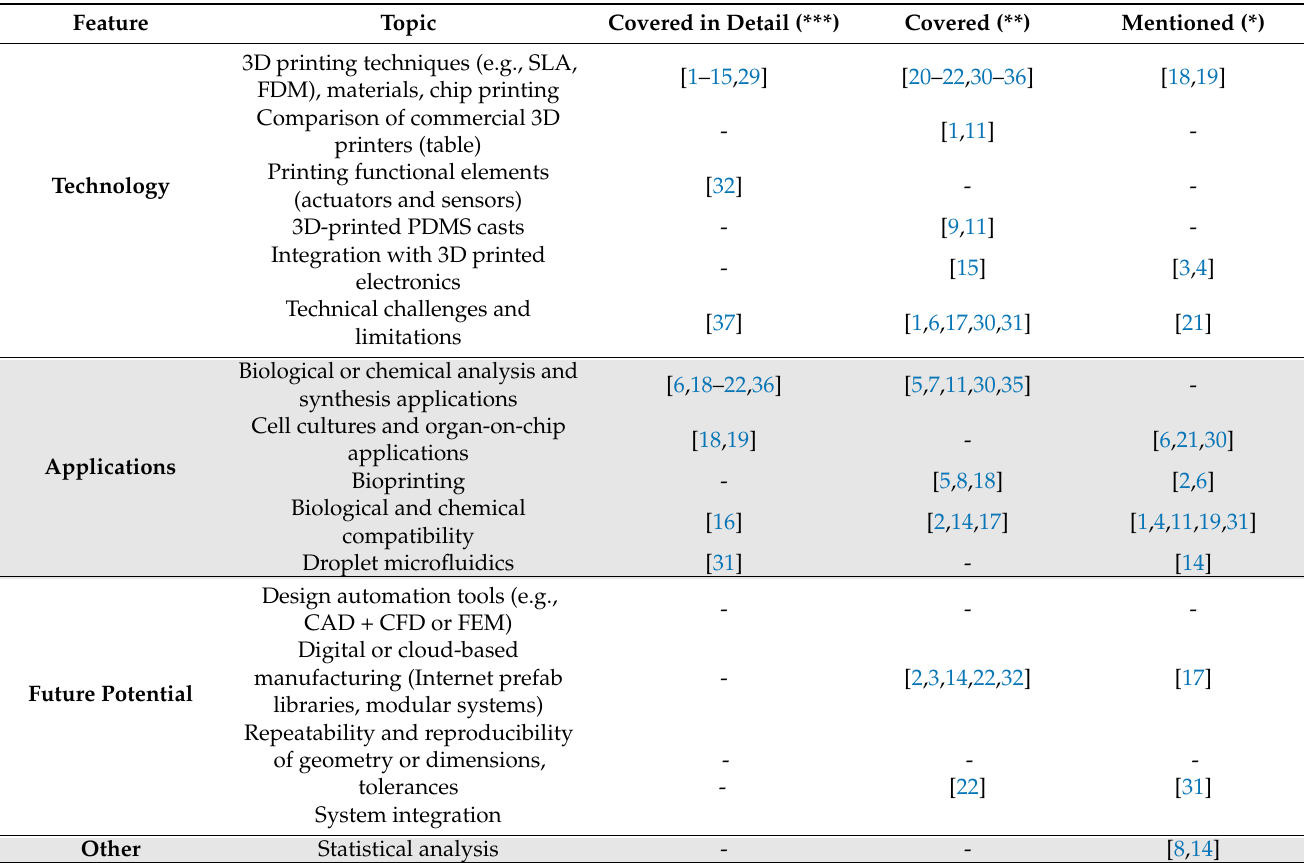
Table 1. Recent review papers on 3DP microfluidics and 3DP droplet microfluidics. * = minimum one paragraph on